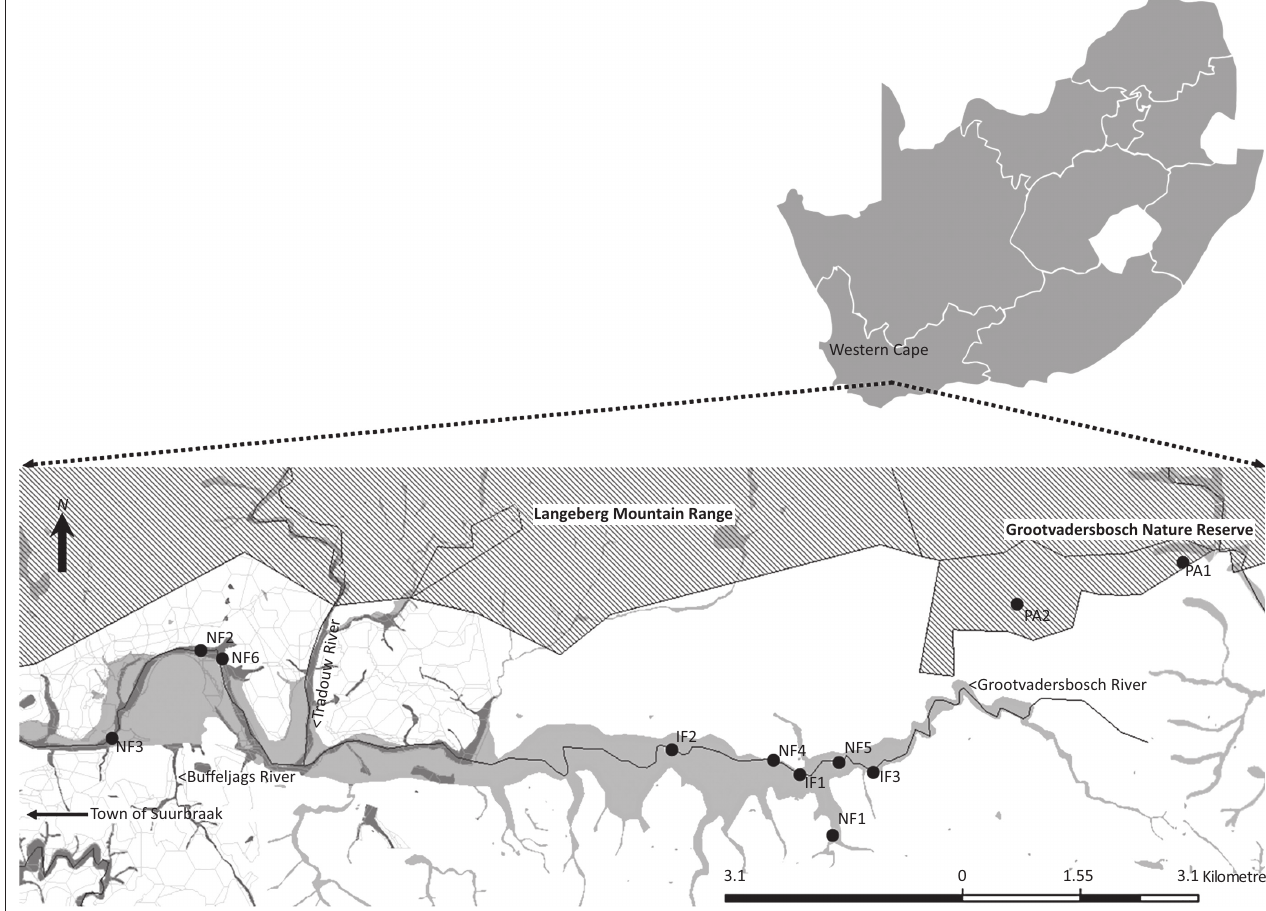
FIGURE 1: Location of study sites within the Grootvadersbosch Conservancy, near the town of Suurbraak in the Western Cape province, South Africa.